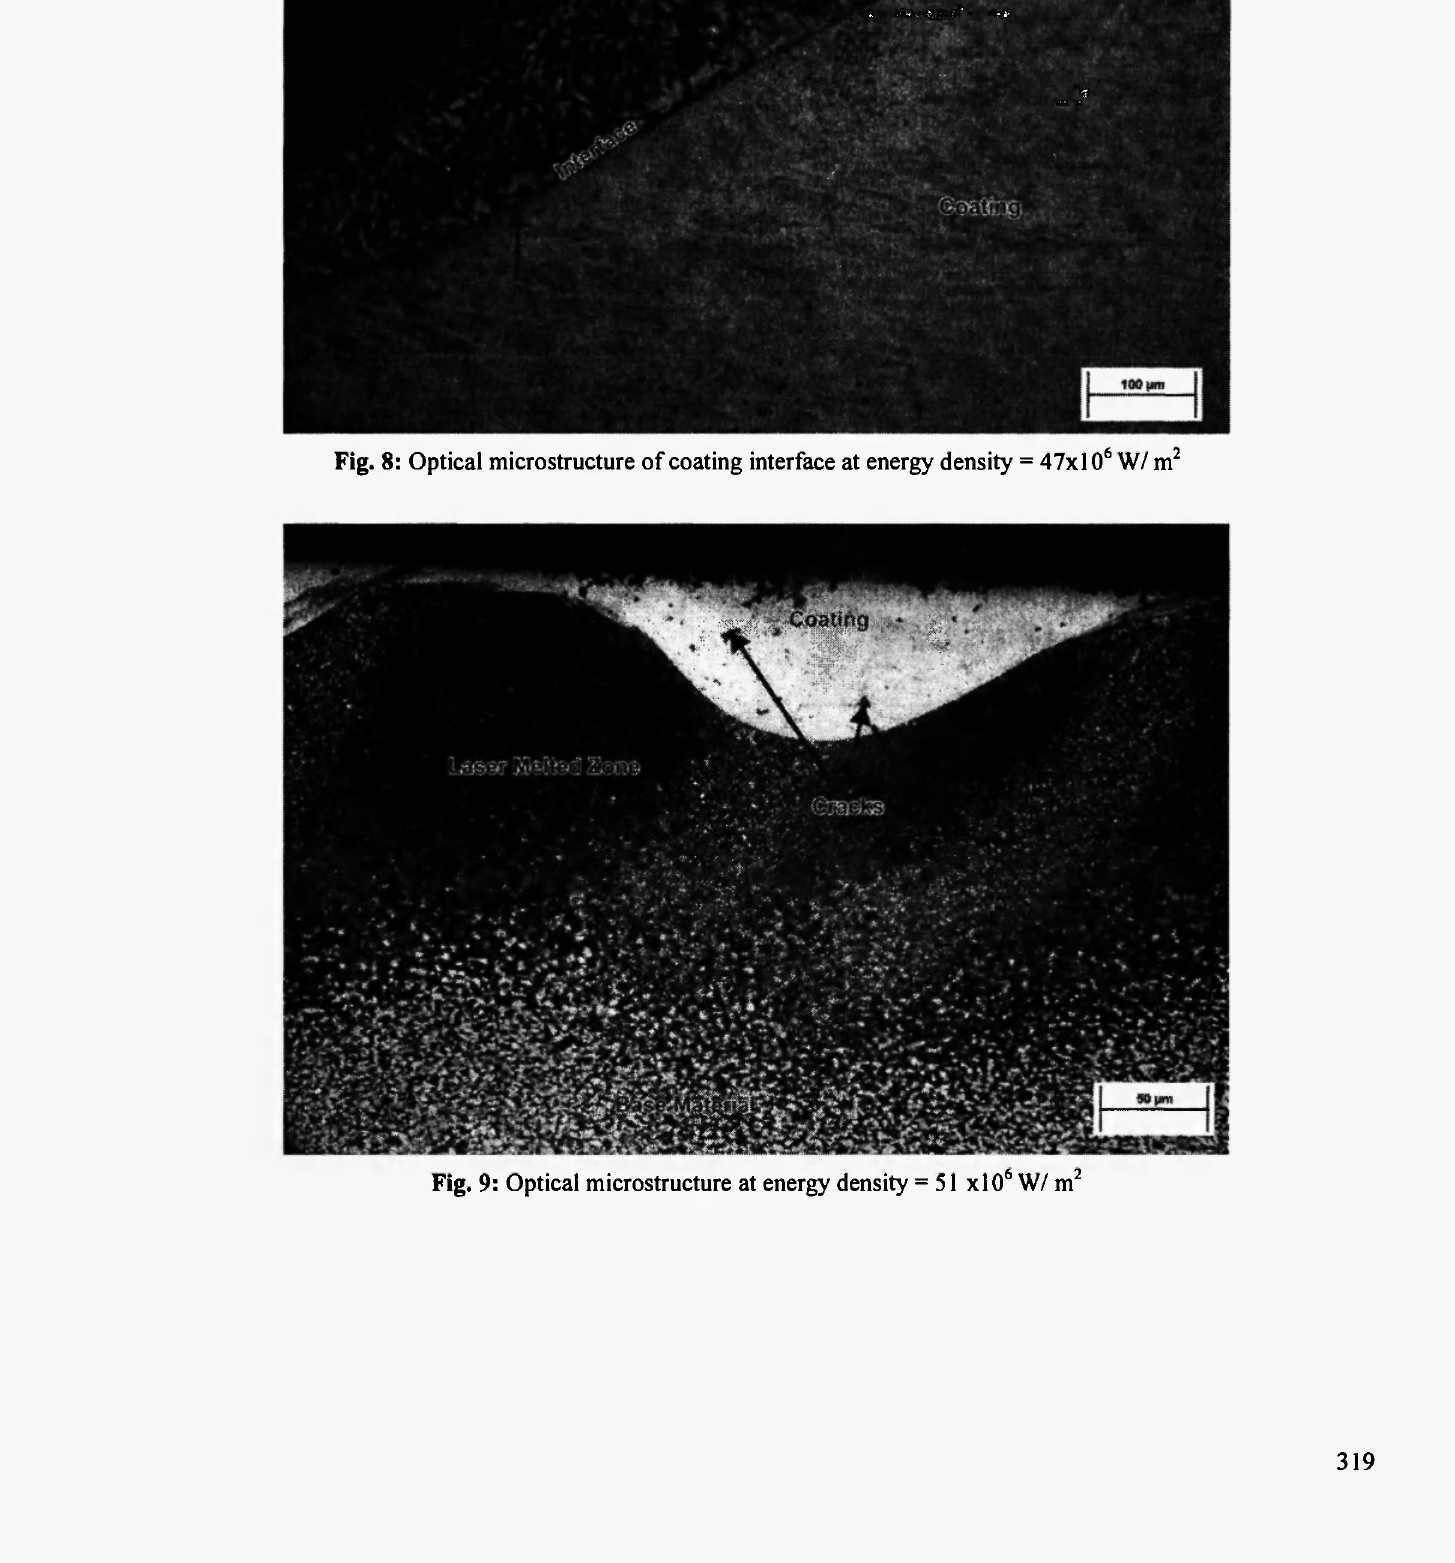
Fig. 9: Optical microstructure at energy density = 51 xlO 6 W/ m 2